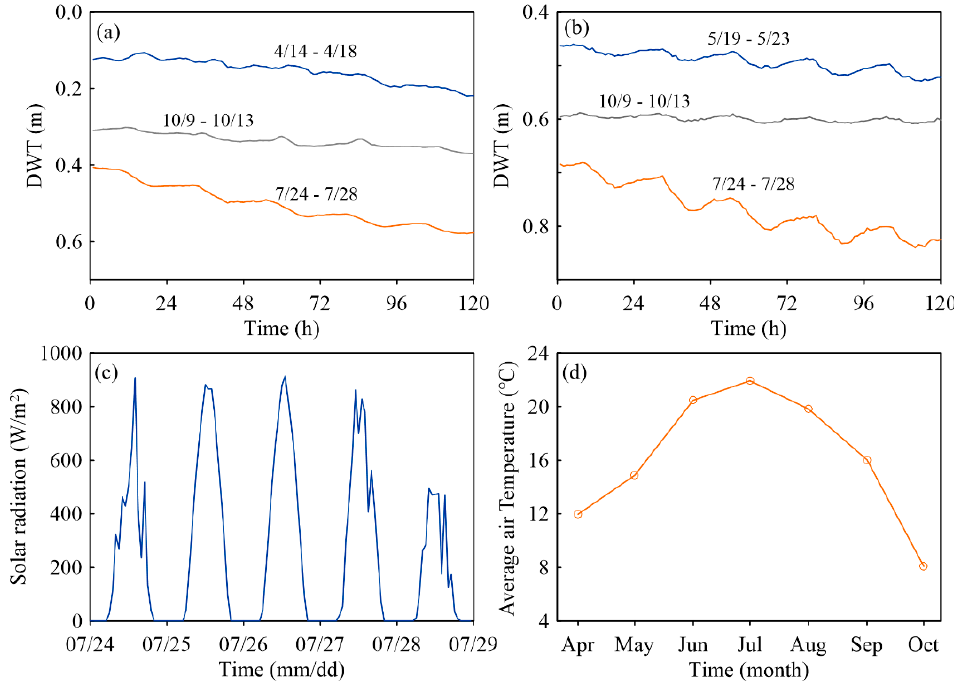
Figure 5. The depth of water table (DWT) of K10 ( a ) and K12 ( b ) at the different periods of the growing season; ( c ) the variation of hourly solar radiation during 24 to 28 July and ( d ) monthly average air temperature.